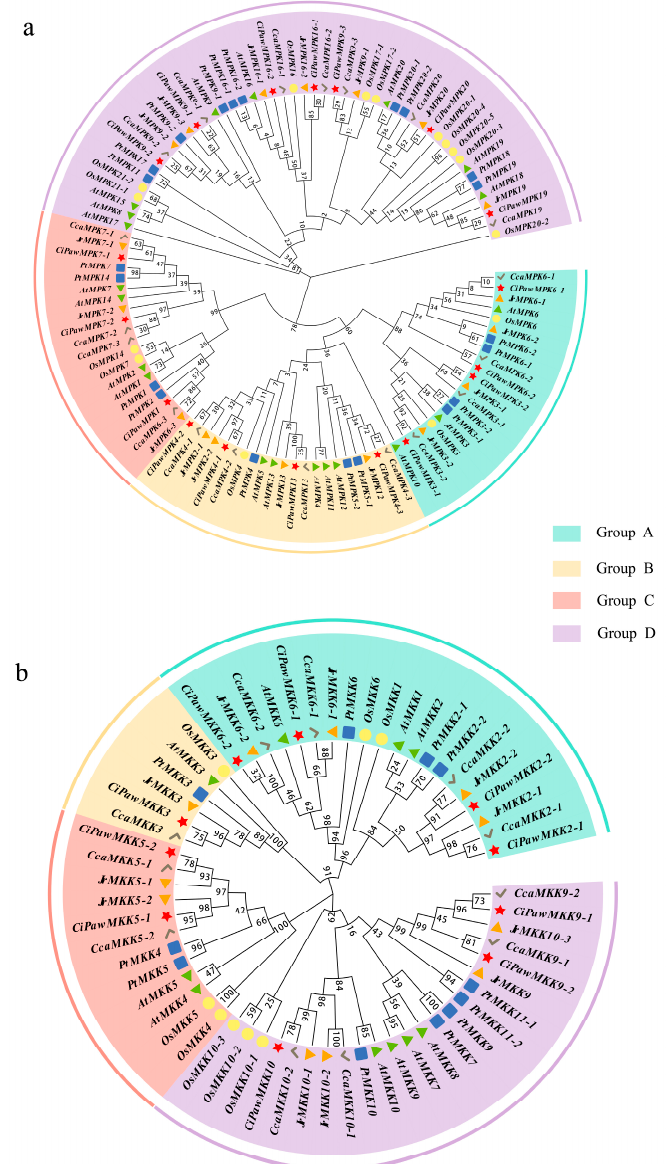
Figure 1. Phylogenetic trees of MPK ( a ) and MKK ( b ) in Arabidopsis , rice, pecan, Chinese hickory, poplar, and walnut. The species were distinguished by different colored shapes. Both MPK and MKK from six species were divided into four groups (group A, B, C, and D). The groups were highlighted in different